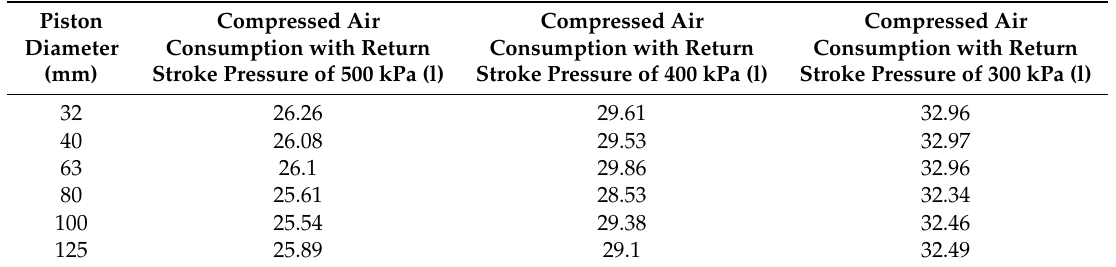
Table 3. The savings in compressed air consumption after second set of measurements.